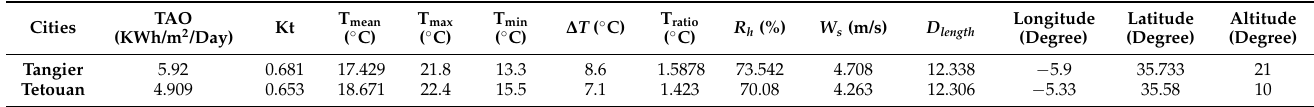
Table 2. Daily average inputs parameters data of Tetouan and Tanger